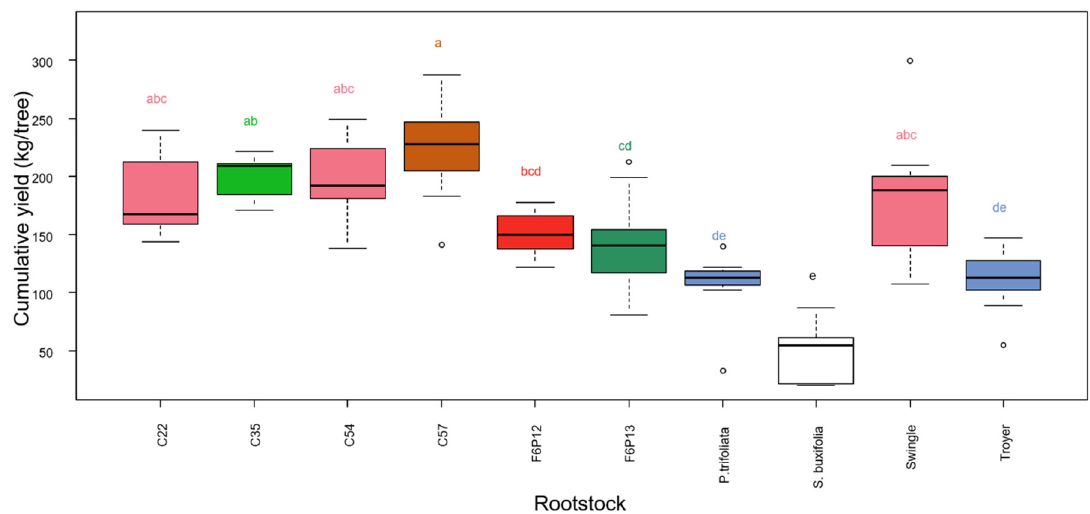
Figure 2. Cumulative yield of Mandared grafted onto 10 rootstocks, calculated from 2015 to 2019. Different letters indicate significantly different means according to Tukey’s test at p < 0.05. Different colors of the boxes indicate different significance groups.